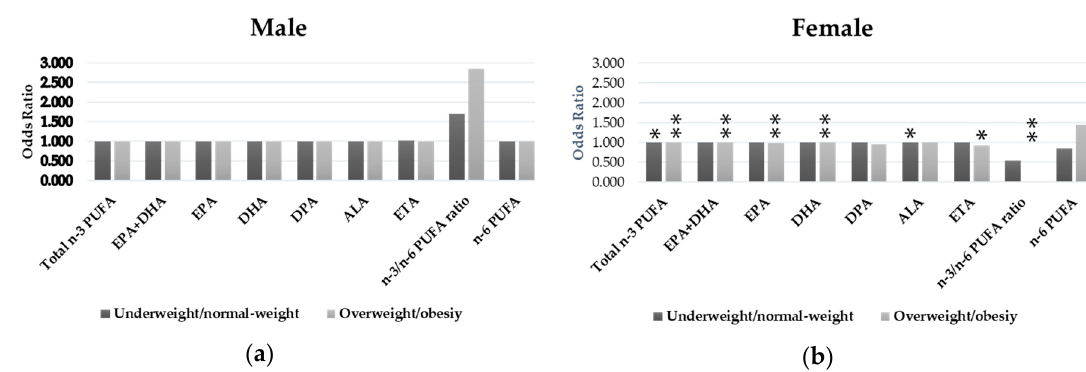
Figure 1. ( a ) Relationships between n-3 PUFAs intake and depressive states in males by weight status (* p -values under 0.05, ** p -values under 0.01), and ( b ) relationships between n-3 PUFAs intake and depressive states in females by weight status (* p -values under 0.05, ** p -values under